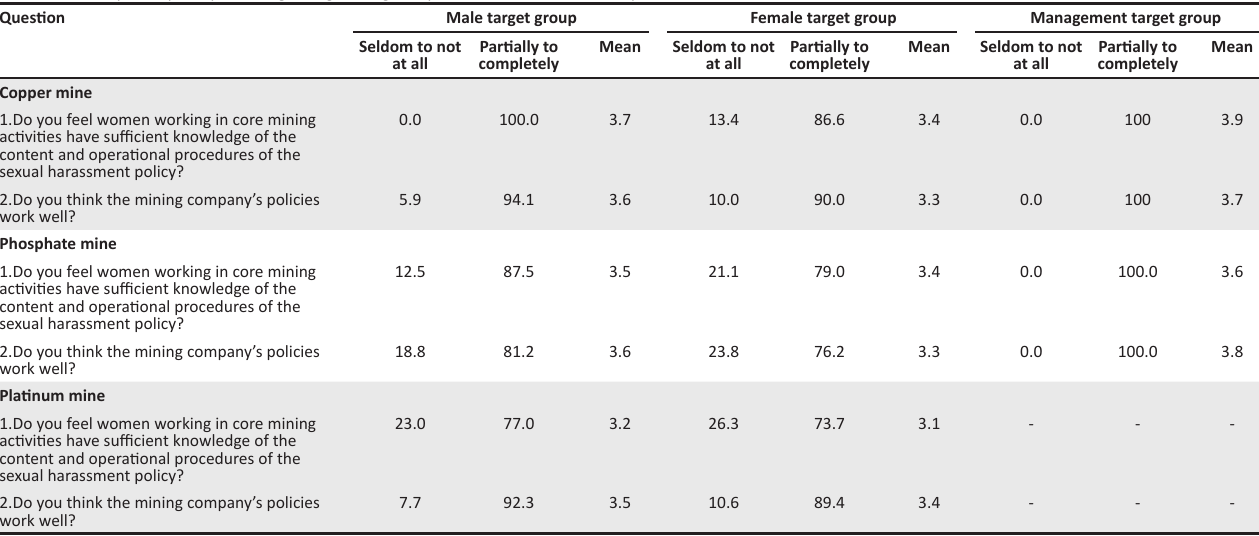
TABLE 2: Participants’ perceptions regarding mining companies’ sexual harassment policies.